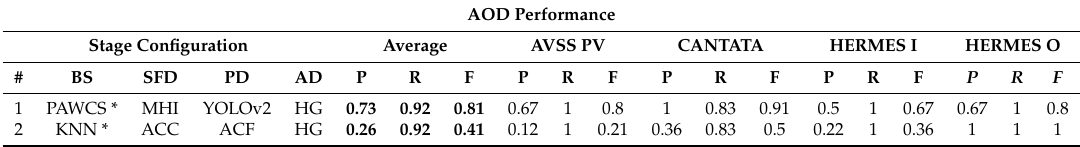
Table 10. Results comparing the approaches of abandoned discrimination for AOD performance. Bold indicates average results. Key: FS = Foreground Segmentation. SFD = Stationary Foreground